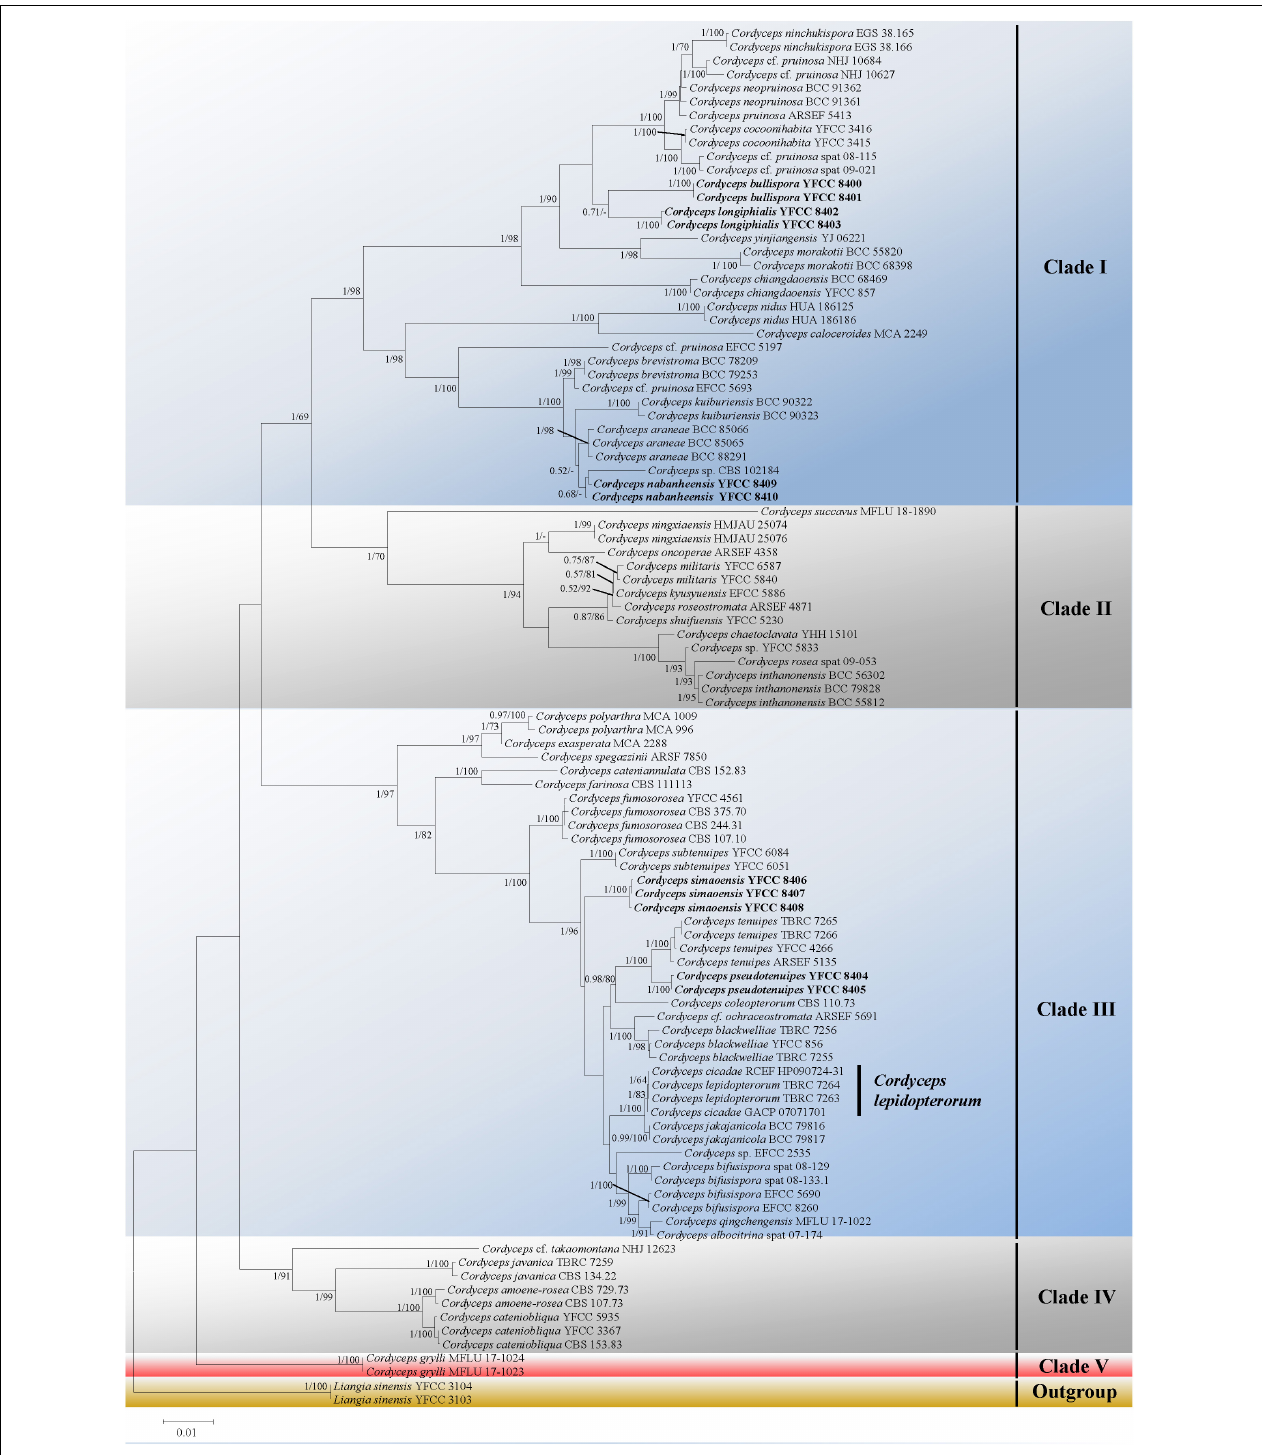
FIGURE 1 | Both ML and BI analyses generate a phylogenetic tree from the concatenated nr SSU , nr LSU , tef-1 α , rpb1 , and rpb2 datasets. There were no discrepancies between the topology resulting from Bayesian and ML analysis for supported nodes. Bootstrap values ( ≥ 60%) derived from ML analyses and posterior probabilities from Bayesian inference ( ≥ 0.50) are shown either above or beneath the branches of the nodes. Isolates in bold type are those analyzed in this study.